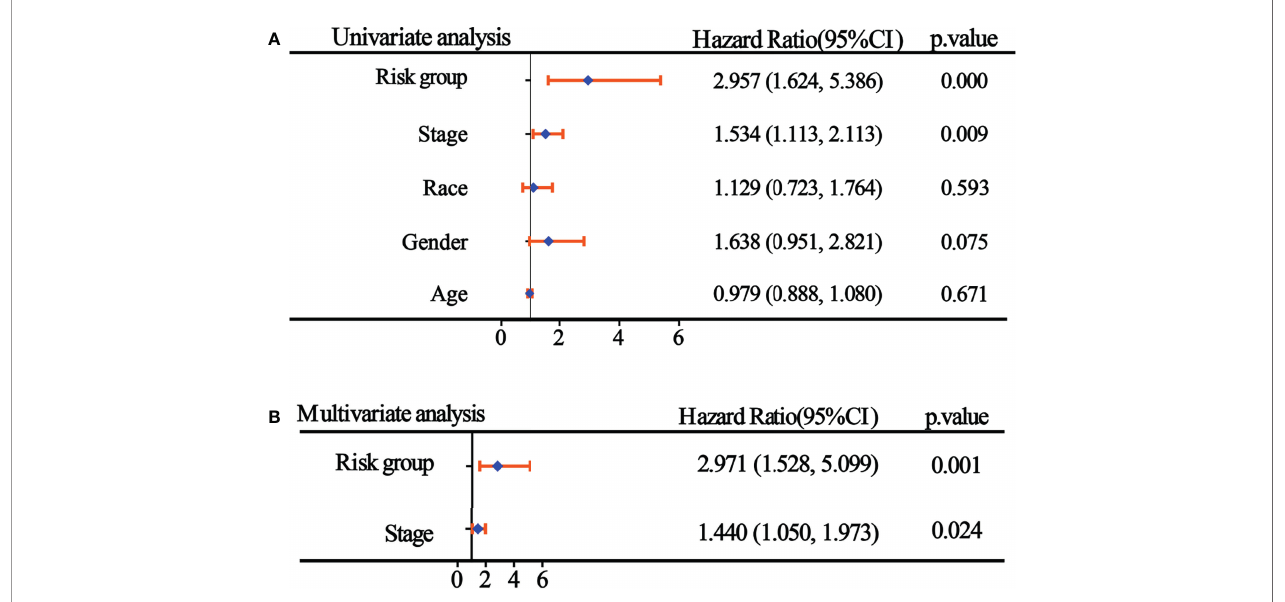
FIGURE 5 | Univariate and multifactor Cox regression analyses of risk score groupings and clinicopathological indicators. (A) Results of single-factor Cox analysis; (B) Results of multifactor Cox regression